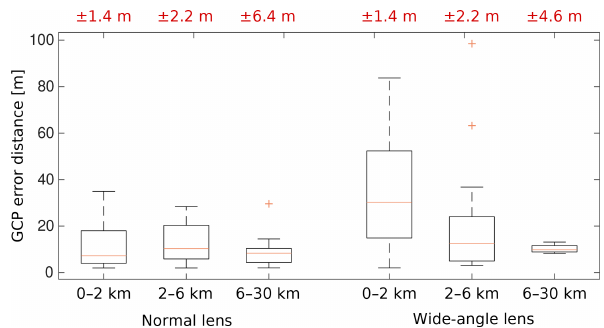
Figure 15. Distance error of the real and projected ground control points (GCPs) for standard and wide-angle lens webcams. Results are grouped in GCPs within 0–2, 2–6, and 6–30km distance to the webcam. Median projection uncertainties are shown as red numbers on top of the